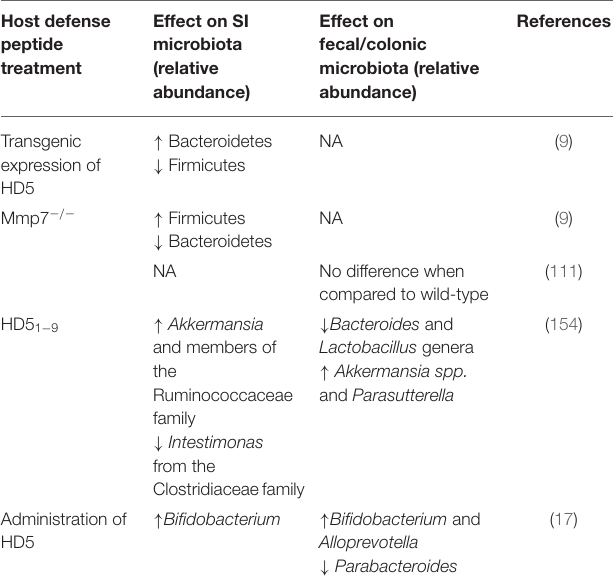
TABLE 1 | Influence of host defense peptides (HDP) on microbiota composition in in vivo